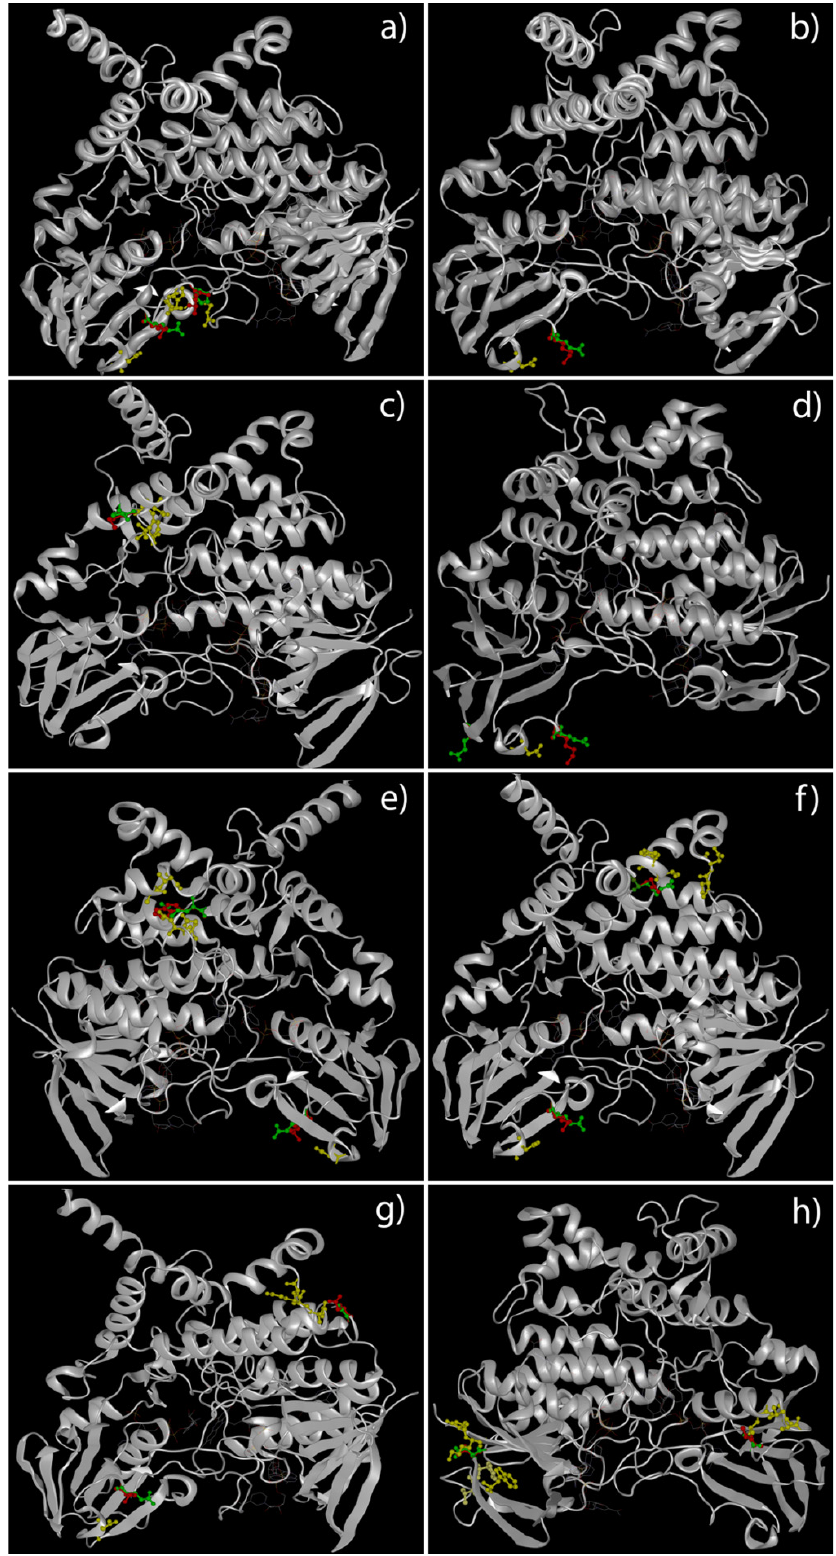
Figure 1. 3D structural models of FMO3 proteins in patients carrying missense variants. This panel highlights the predicted tertiary structure of FMO3 in patients 5 (P153L and E158K) ( a ), 6 (E158K) ( b ), 7 (V257M) ( c ), 8 (E158K and E308G) ( d ), 9 (E158K and R492W ( e ), 10 (E158K and R238Q) ( f ), 11 (E158K and G475D) ( g ) and 12 (D141V and G180V) ( h ). Green ball-and-stick aa = wild-type aa. Red ball-and-stick aa = mutated aa. Yellow ball-and-stick aa = aa nearest to aa involved in variant.